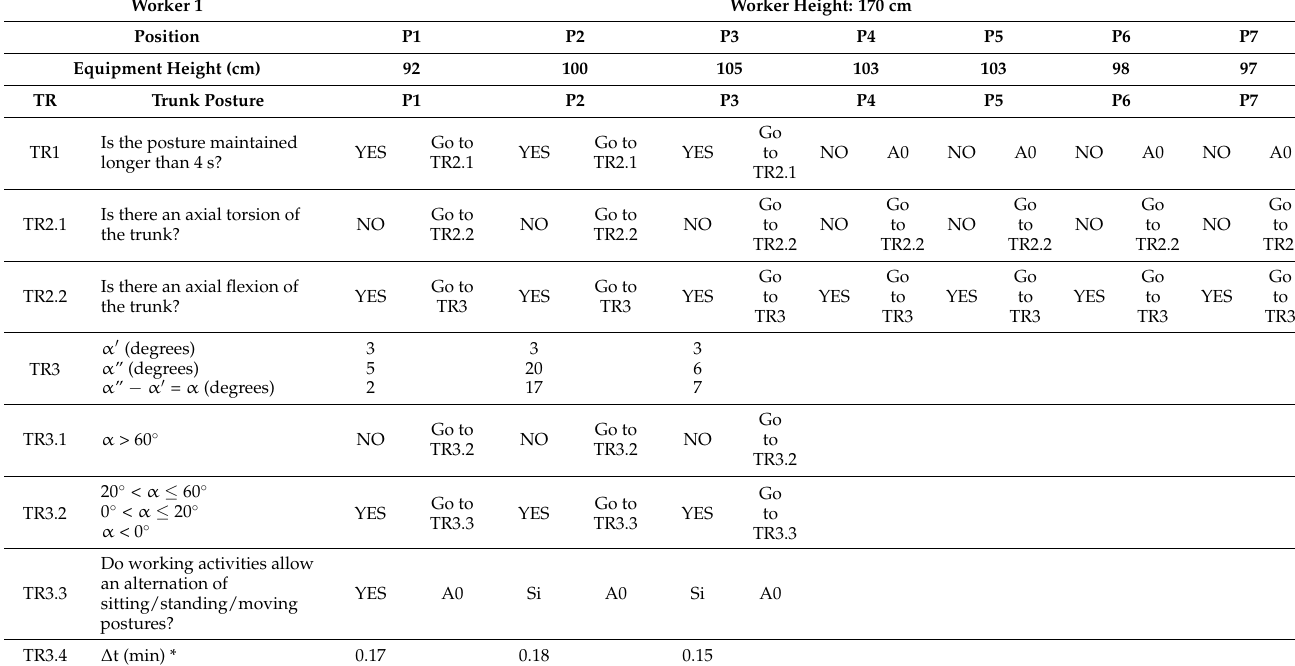
Table A1. Trunk posture evaluation.